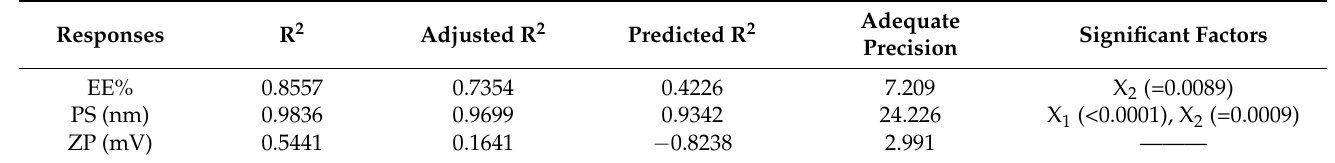
Table 6. Output data of the full factorial analysis of TOL-cosolvent